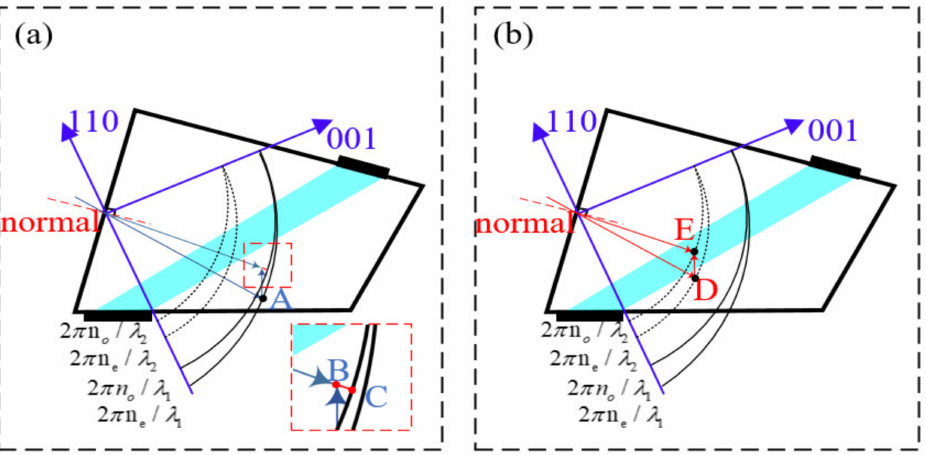
Figure 1. Wave diagram of anisotropic AO diffraction. Momentum mismatching ( a ) and momentum matching ( b ) under oblique